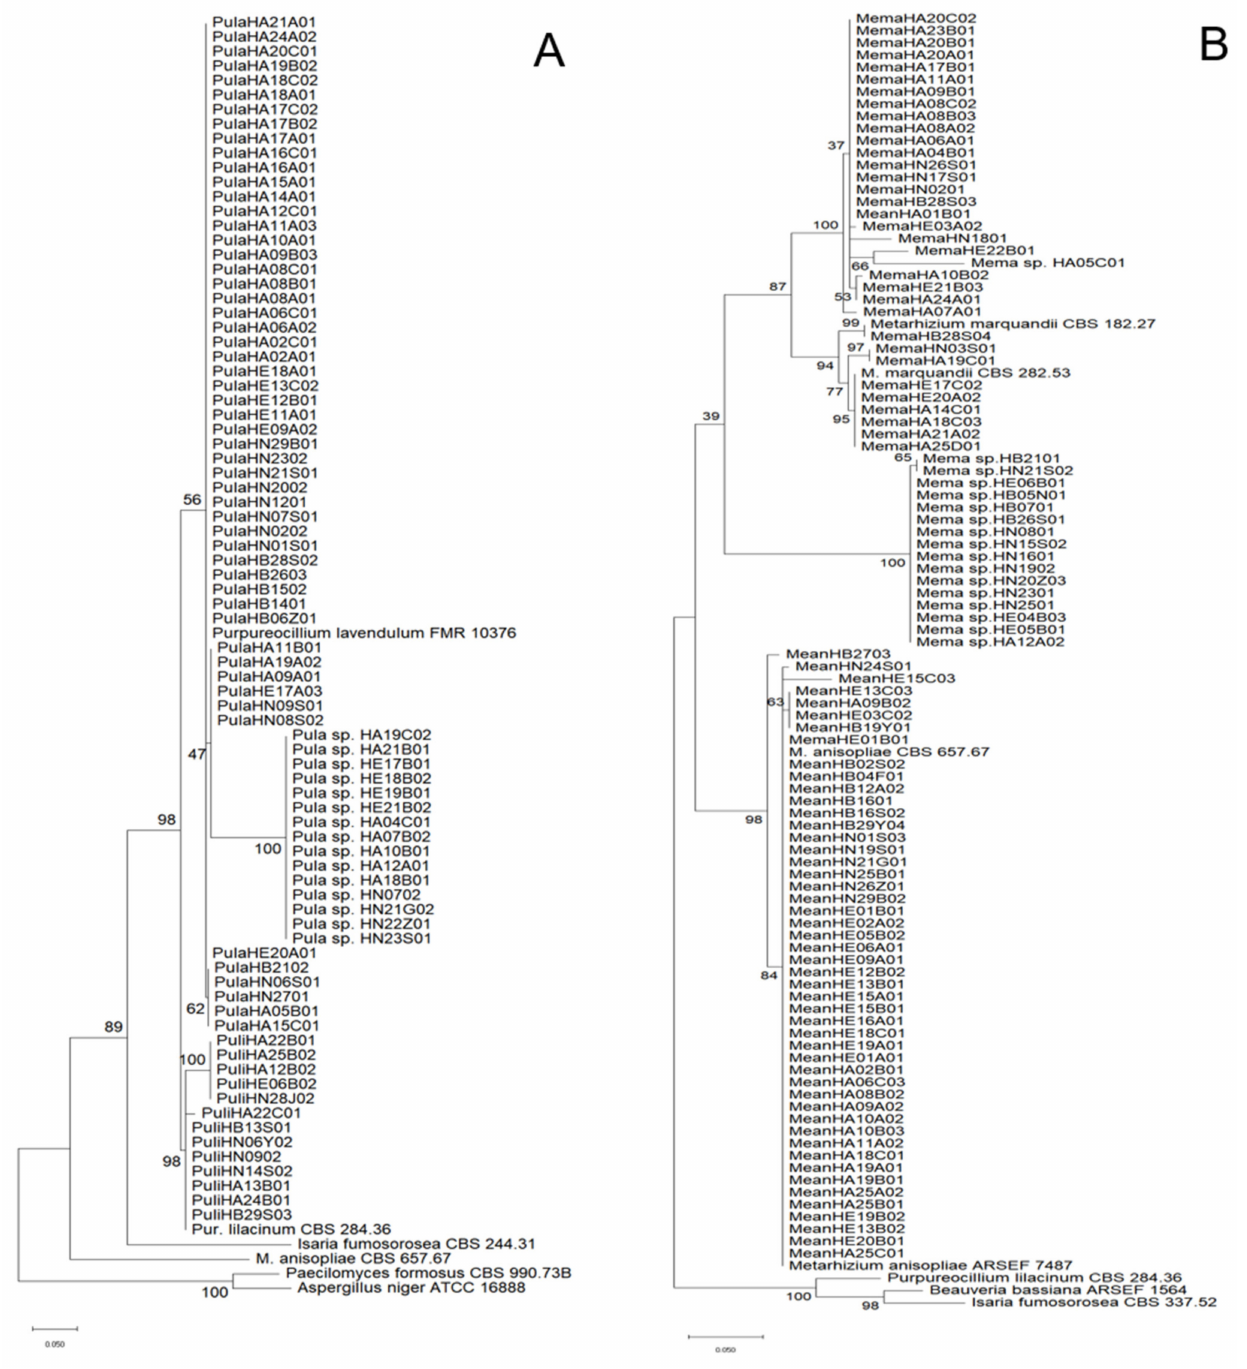
Figure 1. Phylogenetic tree of Purpureocillium spp. ( A ) and Metarhizium spp. ( B ) isolates. 3.4. The Pathogenicity of Fungal Isolates against P. striolata Forty-seven isolates were subjected to a bioassay against P. striolata . The results indicate that I. javanica (IsjaHN3002) had the highest mortality, and Aspergillus spp., Fusar- ium falciforme , Lecanicillium spp., Metarhizium spp. and Talaromyces spp. all had obvious pathogenicity against P. striolata (Table